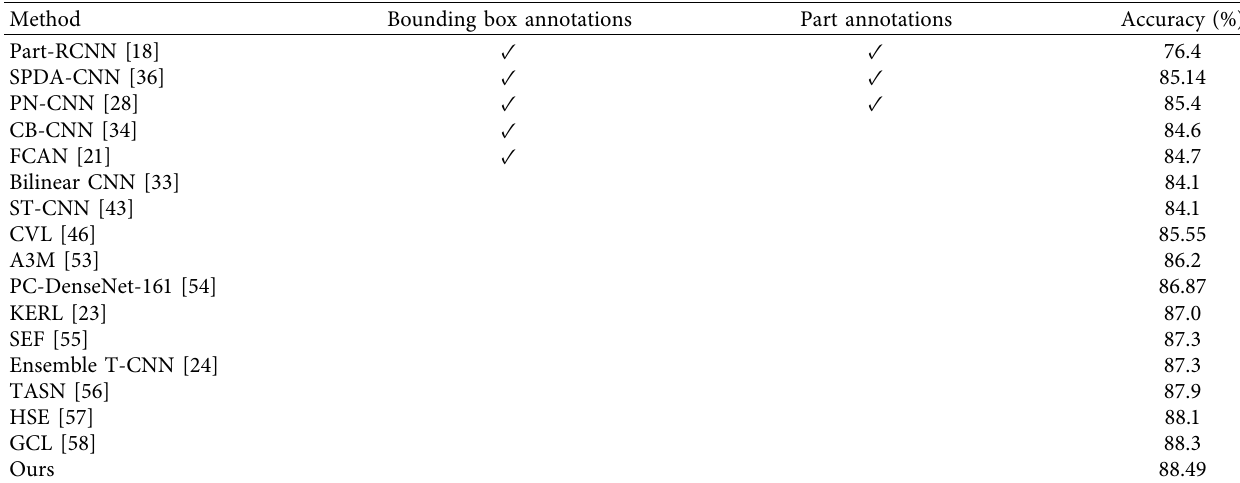
Table 2: Experimental results on Caltech-UCSD Bird dataset.